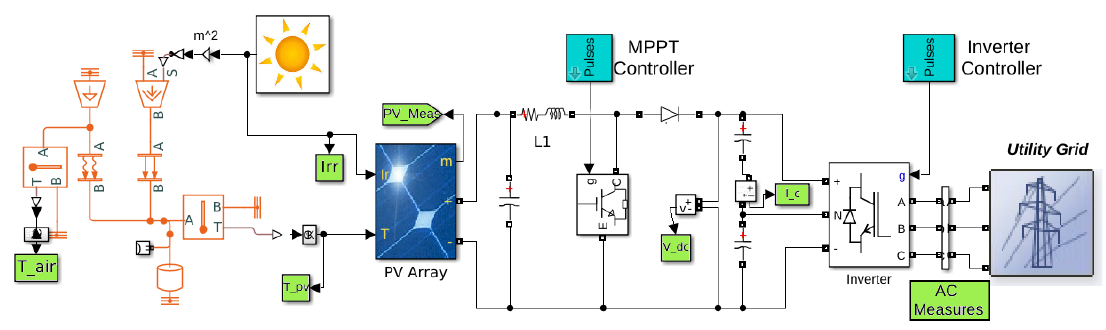
Figure 3. Simulated environment on Simulink.